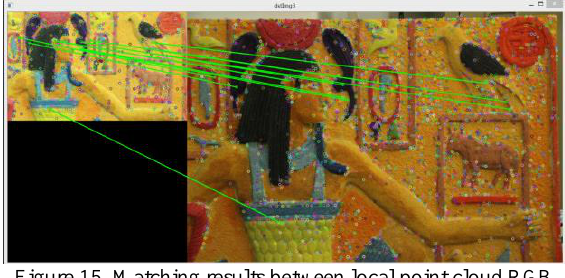
Figure 15. Matching results between local point cloud RGB images and local images